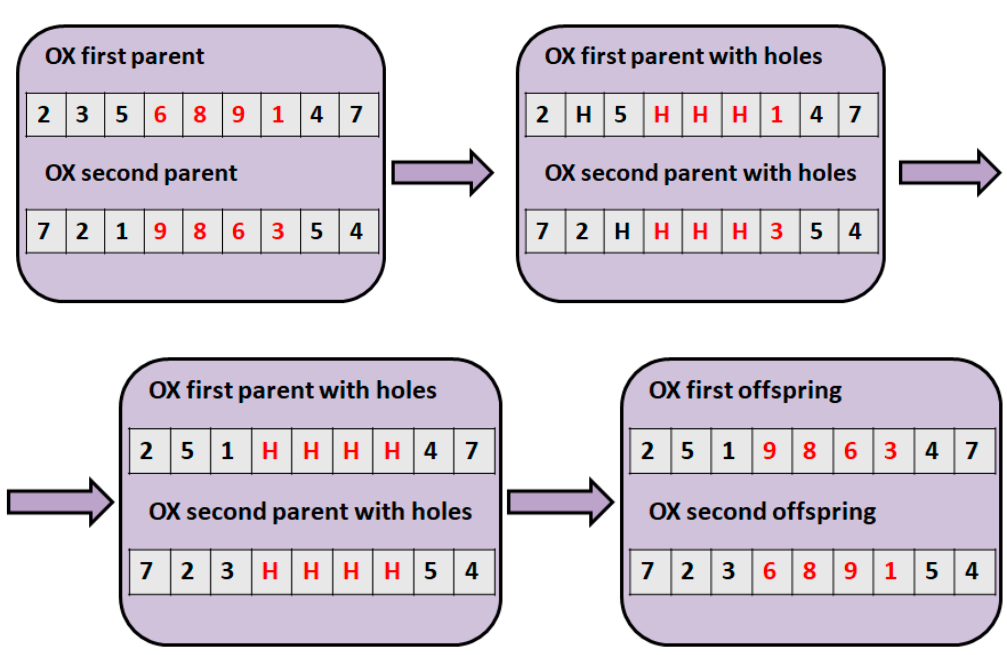
Figure 4. The order crossover (OX).